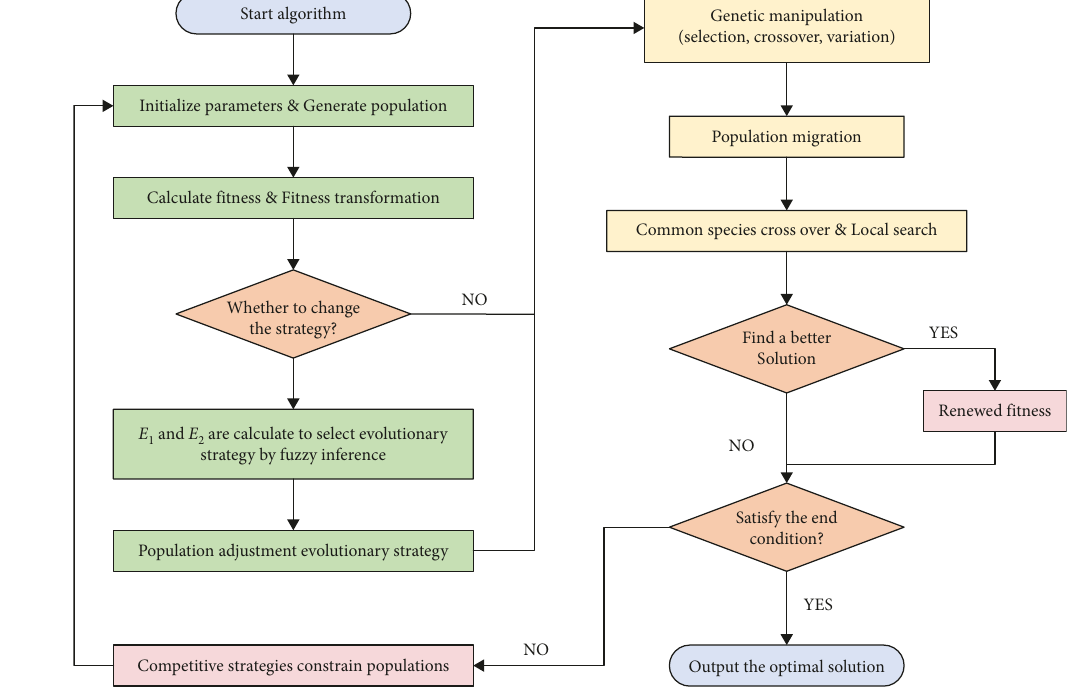
Figure 4: Flowchart of FAPGA.